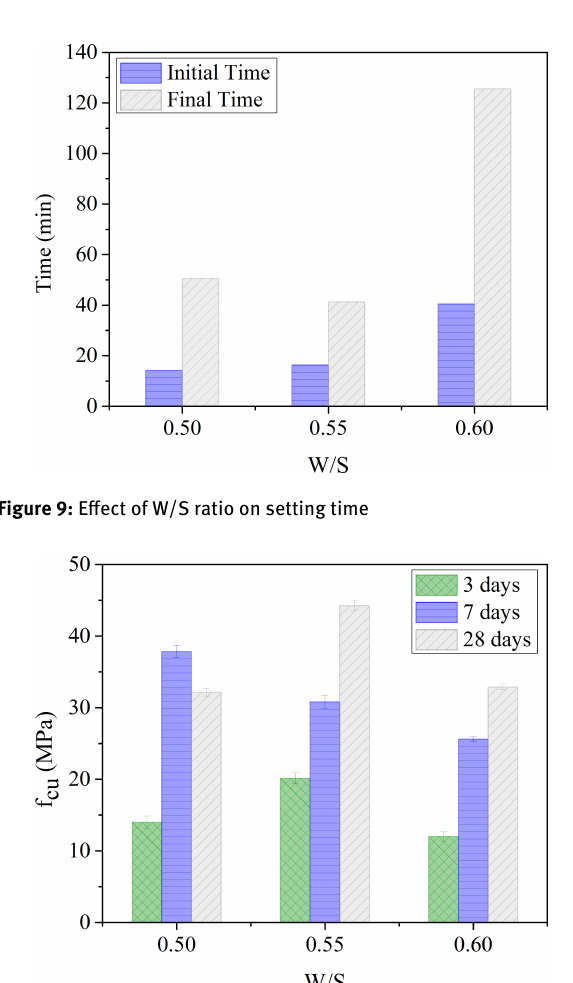
to 40 min and 120 min for initial and final setting time respectively comparison to other samples. However, S4.4